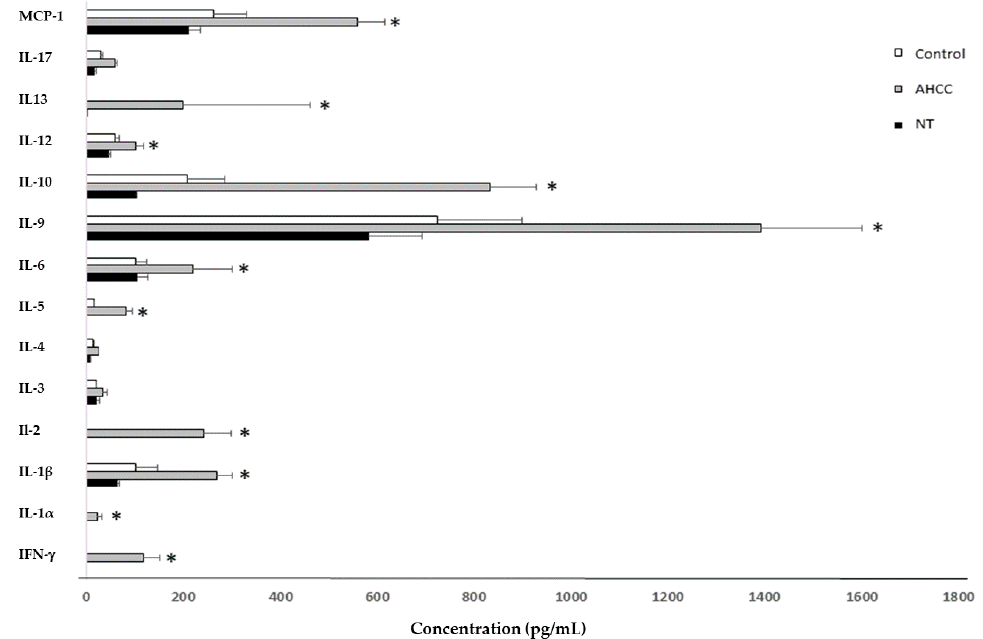
Figure 2. Comparison of cytokine production by lymphocytes isolated from BALB/c mouse spleen after 24 h exposure to nucleotides (NTs) and AHCC. * p < 0.05 versus the control.